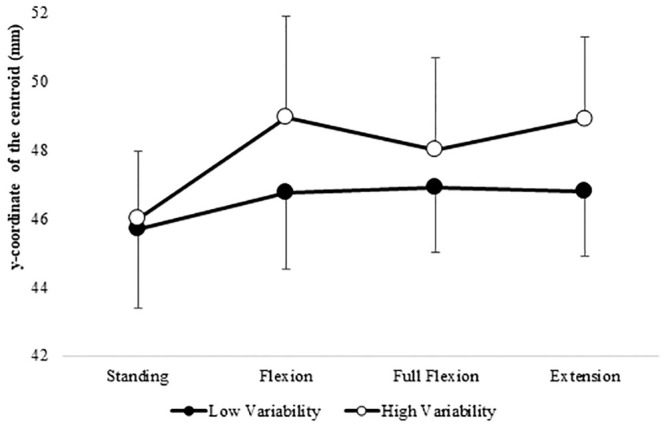
The difference in the y-coordinate of the centroid between the low-variability and high-variability groups.The mean (±SD) of the y-axis coordinate of the centroid of the RMS map estimated in the standing phase, flexion phase, full flexion phase, and extension phase of the standing forward bending task. The high-variability group tended to show greater changes in the y-coordinate of the centroid compared to the low-variability group.